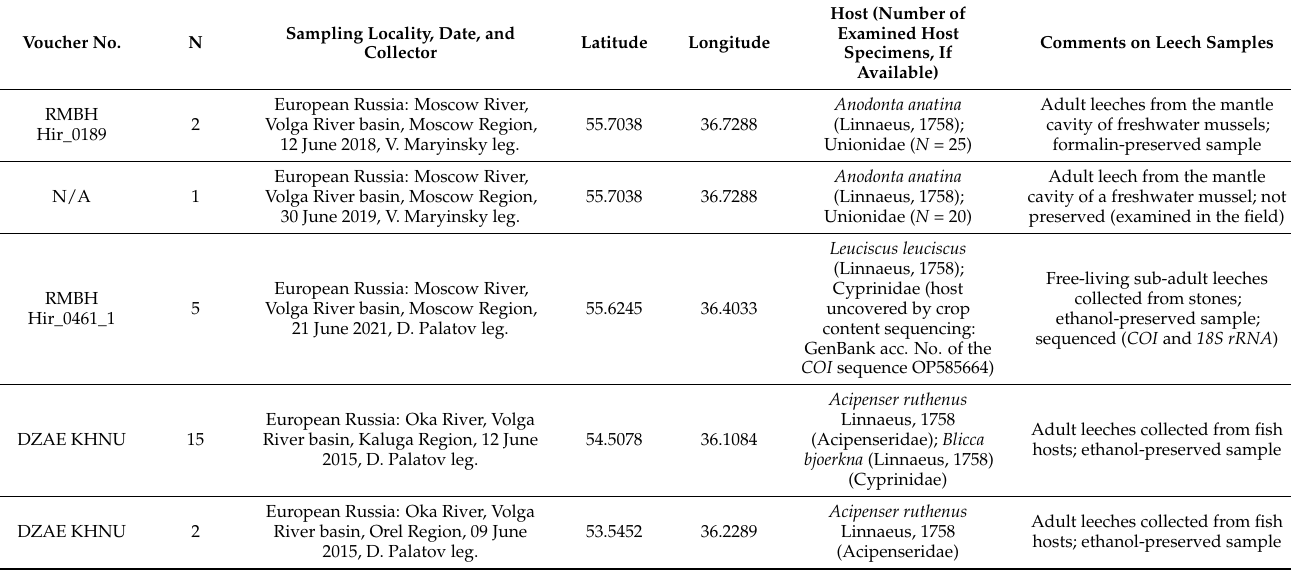
Table 1. Samples and hosts of Acipenserobdella volgensis (Zykoff, 1904) (Hirudinea: Piscicolidae) examined in this